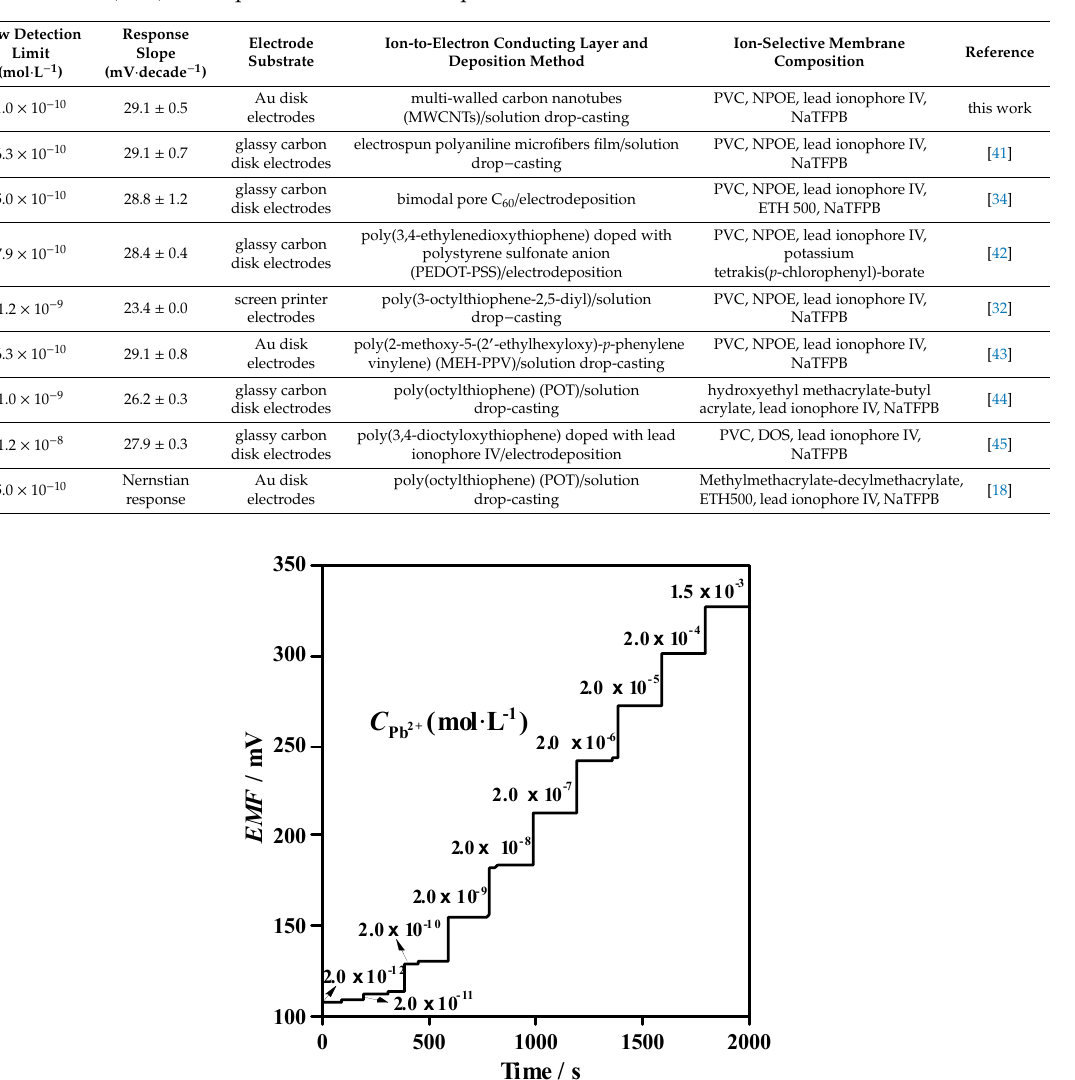
Table 2. Response characteristics and sensor construction of Au / MWCNTs / (MMA-BA)-Pb 2 + ion-selective electrodes (ISEs) in comparison with those of reported Pb 2 + -selective solid-contact electrodes.